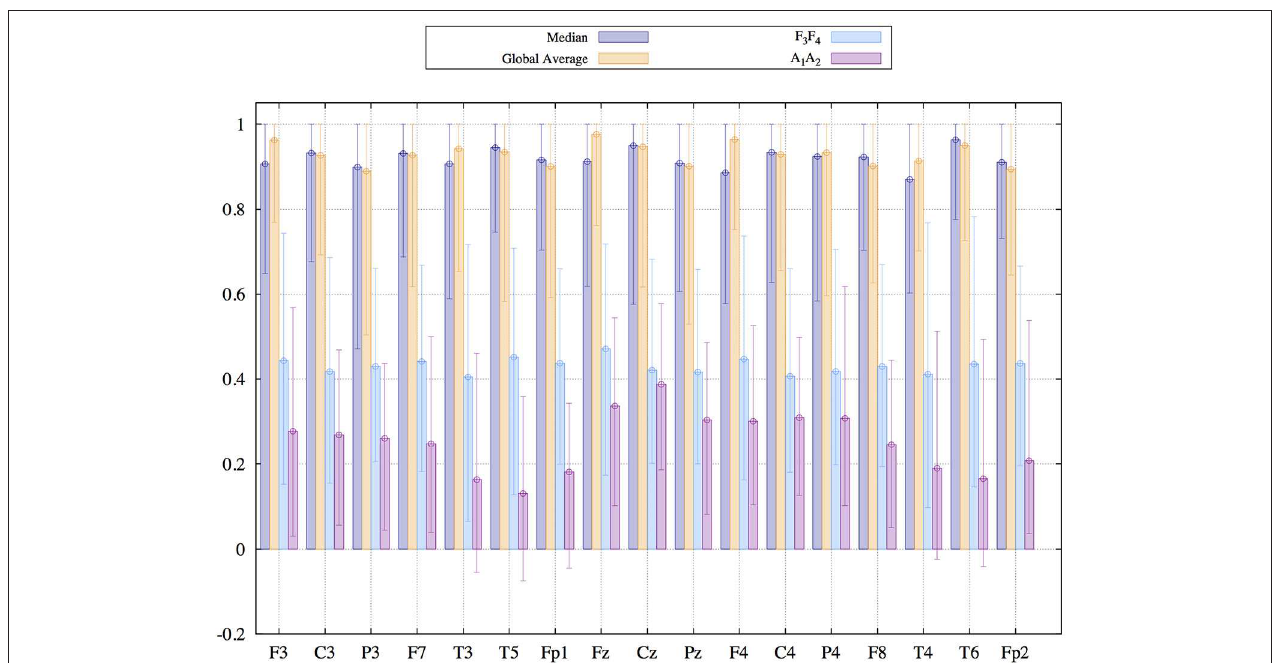
FIGURE 9 | Median and 95 % confidence interval of the Pearson coefficient comparing signals recorded by the same electrode before and after the application of Independent Component Analysis for the elimination of eyelid-movement. EEG recordings stem from data set three described in the method section.